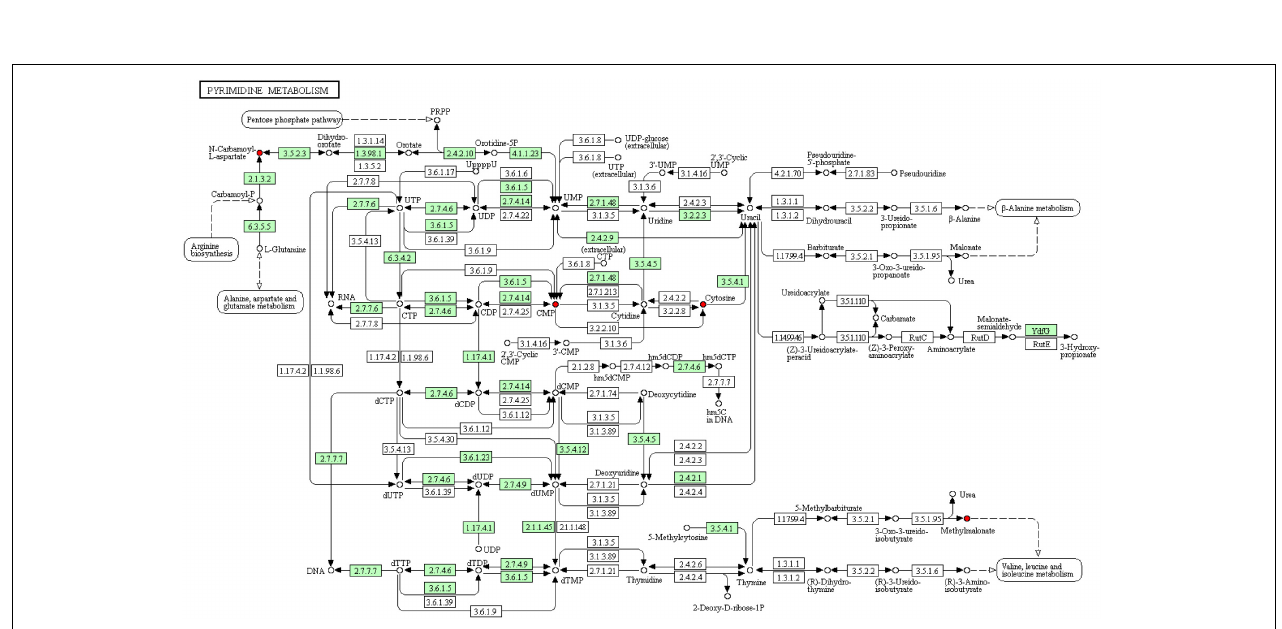
FIGURE 8 | Pyrimidine metabolic pathways in mycelia after physiological maturation. Red cycle indicates up-regulated metabolite, arrow indicates reacted direction. Small green box represents the enzyme specific to the species. Dotted line indicates relationships with other metabolic pathways. Big cycle box represents other metabolic